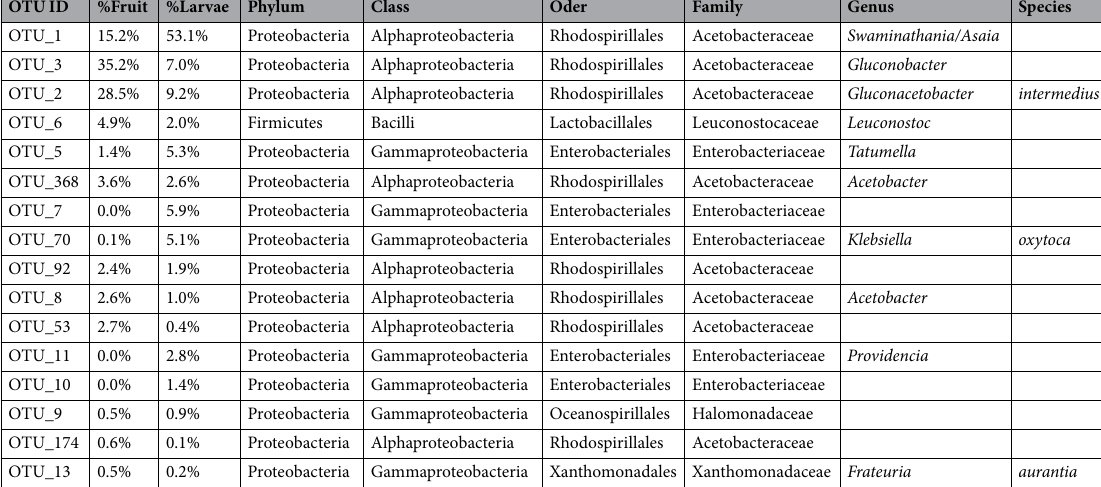
Table 1. Taxonomic identification of the of the 16 most abundant bacterial OTUs in the larvae and